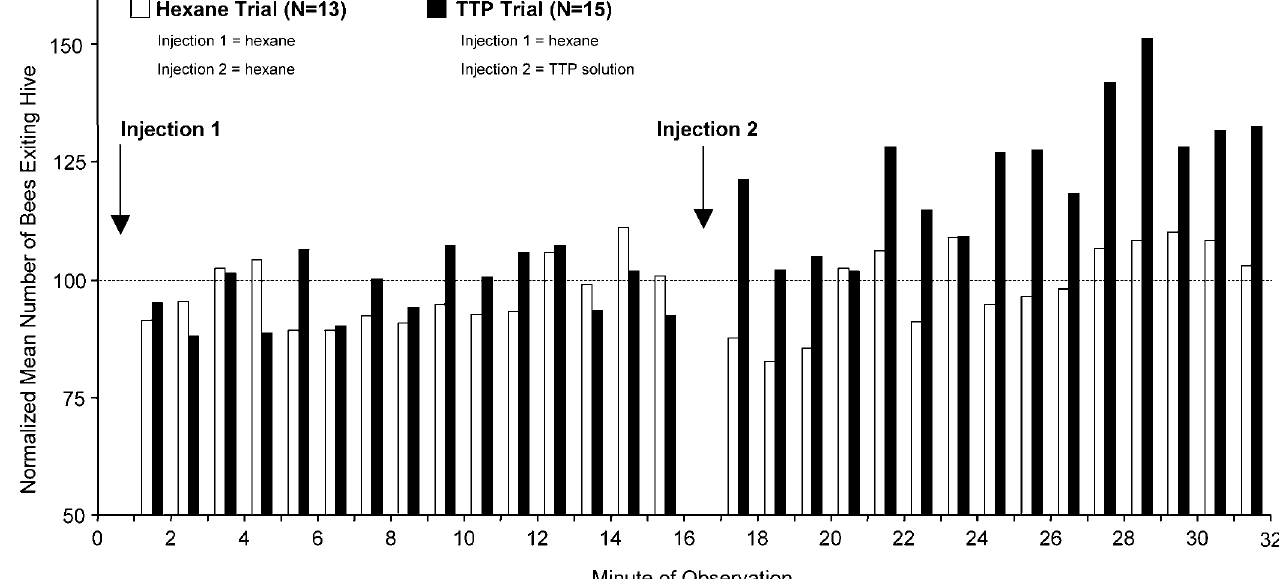
Figure 4. Injection of Scent and Behavioral Response Comparison of foraging activity in Colony 2 following injection of the TTP solution versus pure hexane. The normalized mean number of bees exiting the hive following Injection 2 (during minutes 25–32) was greater during TTP trials (black bars) than during Hexane trials (white bars). Results were similar for Colony 1. Statistical tests are given in the text.